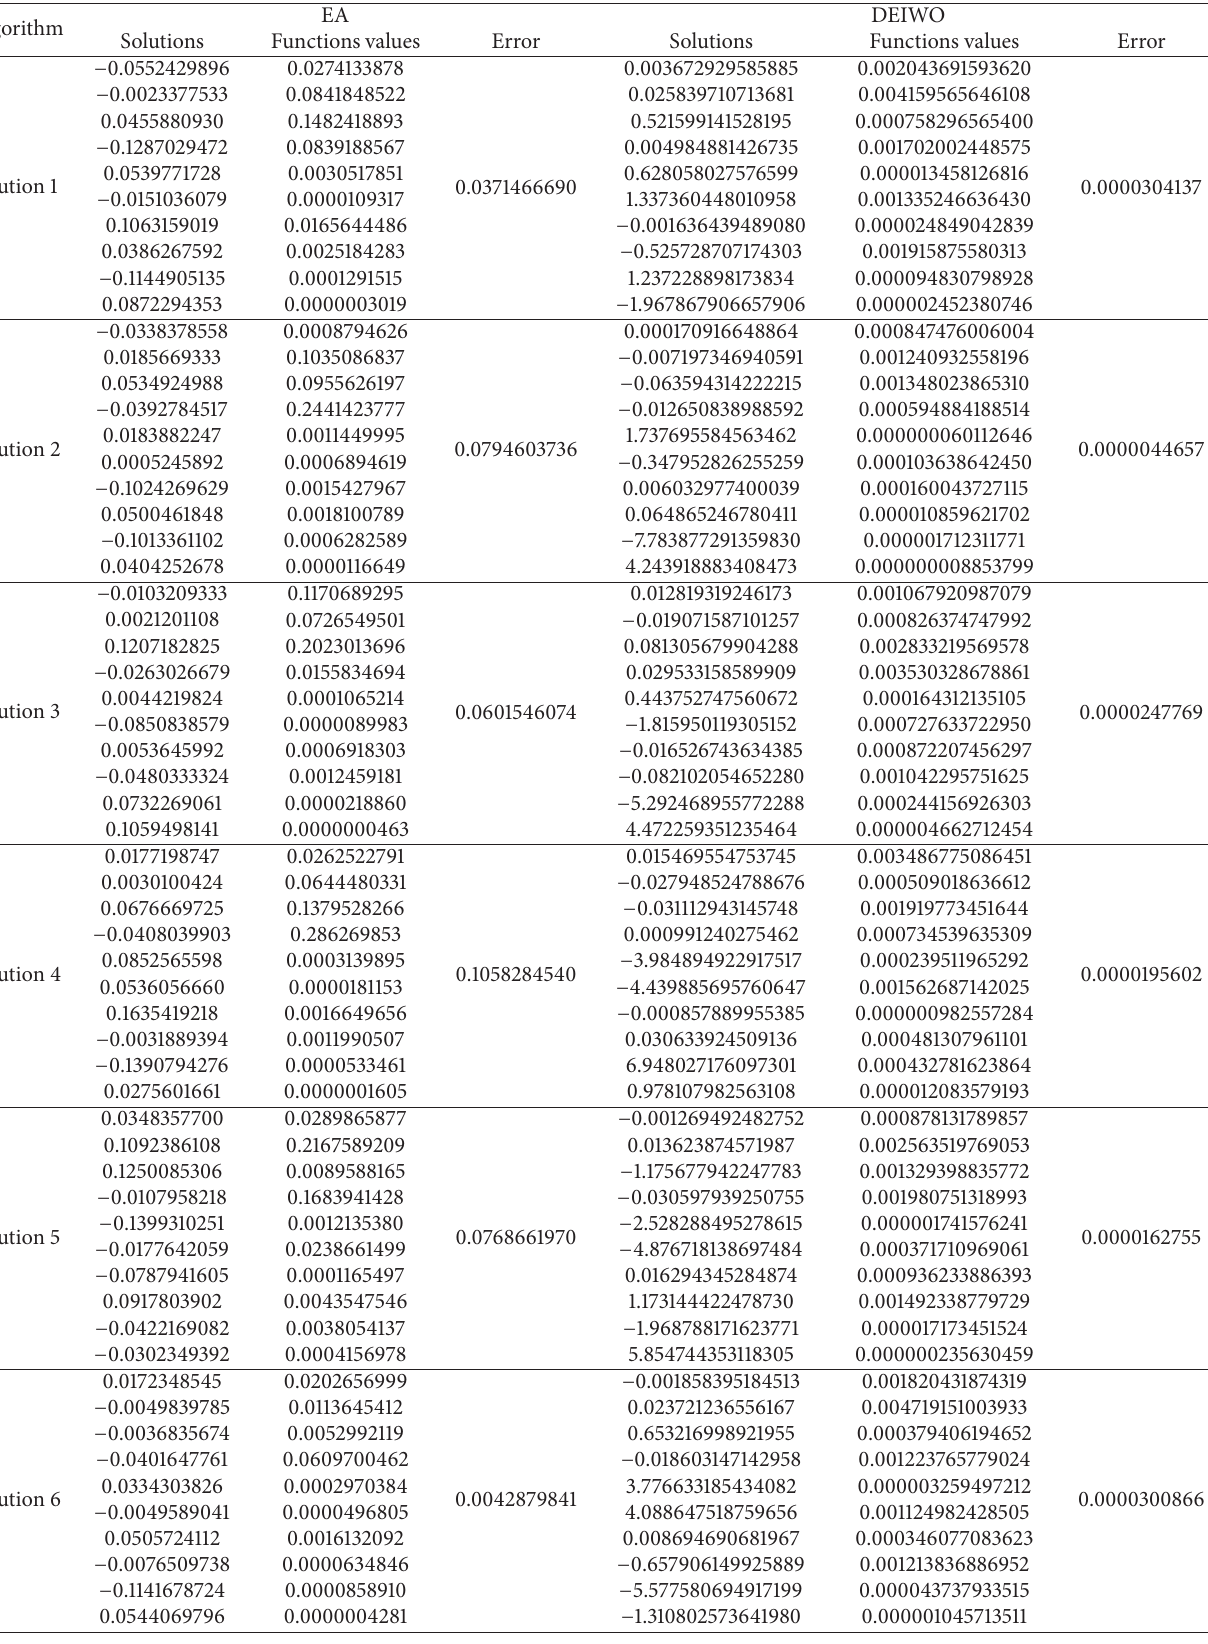
Table 10: Comparison of results for combustion application